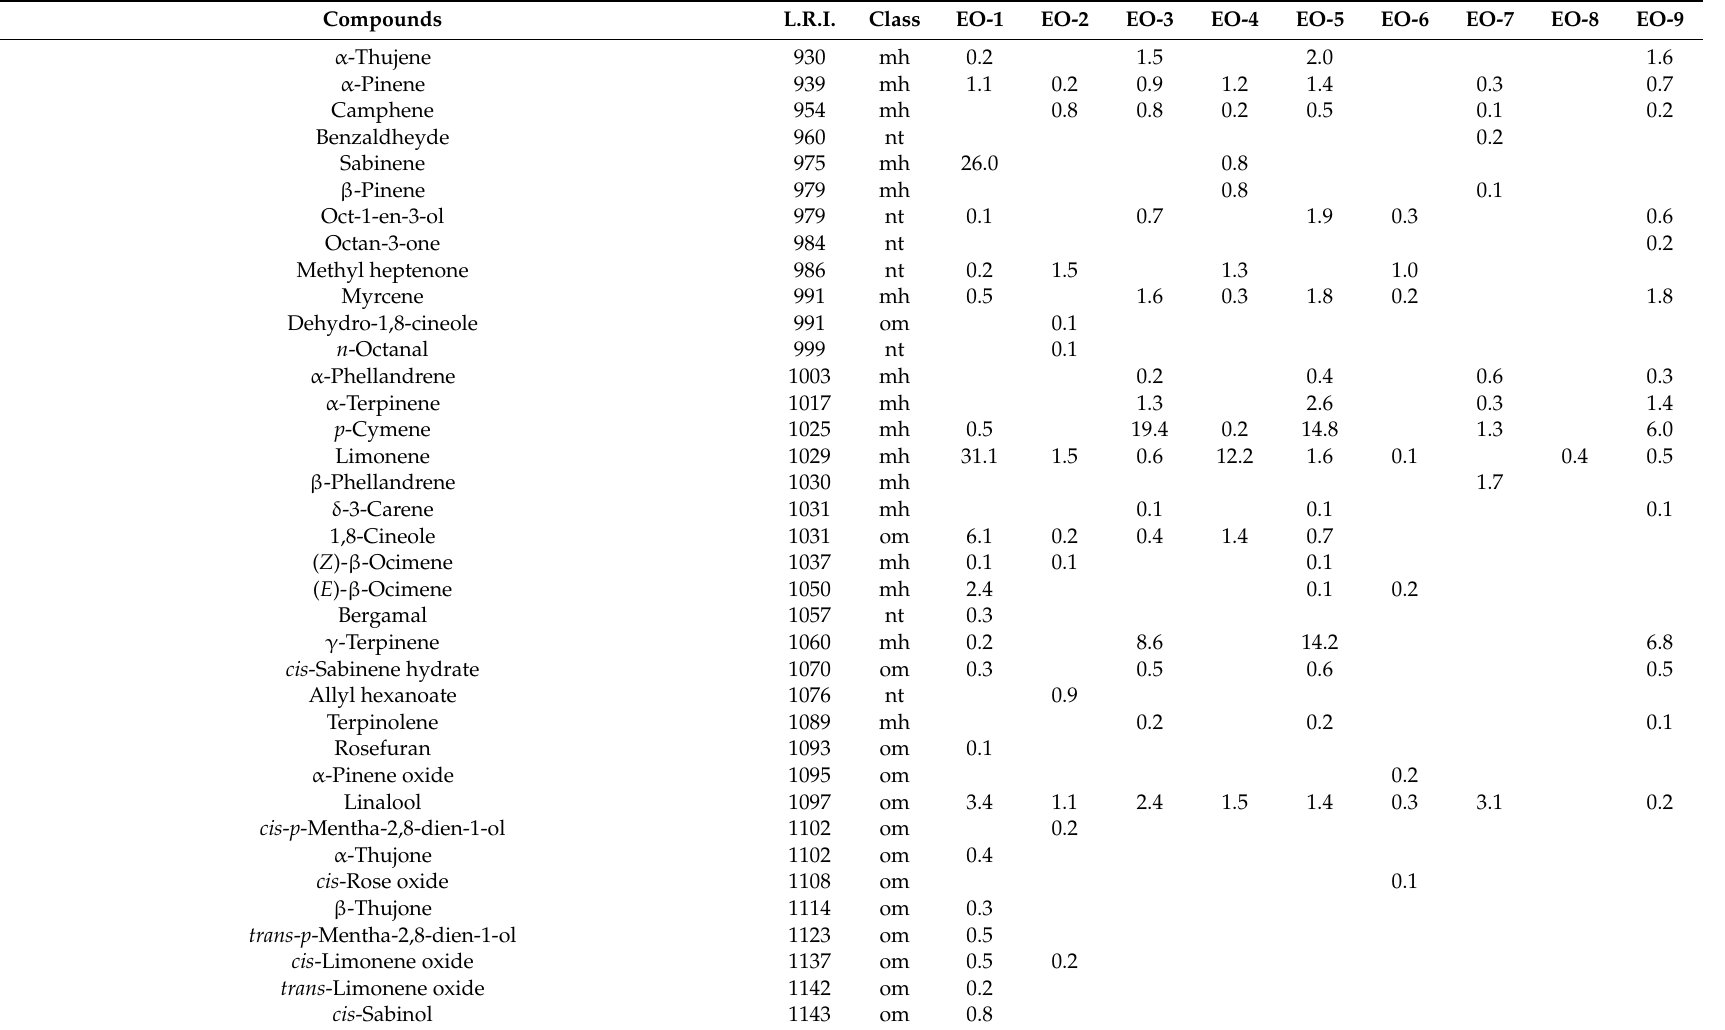
Table 1. Relative percentage of the main constituents of the tested essential oils.